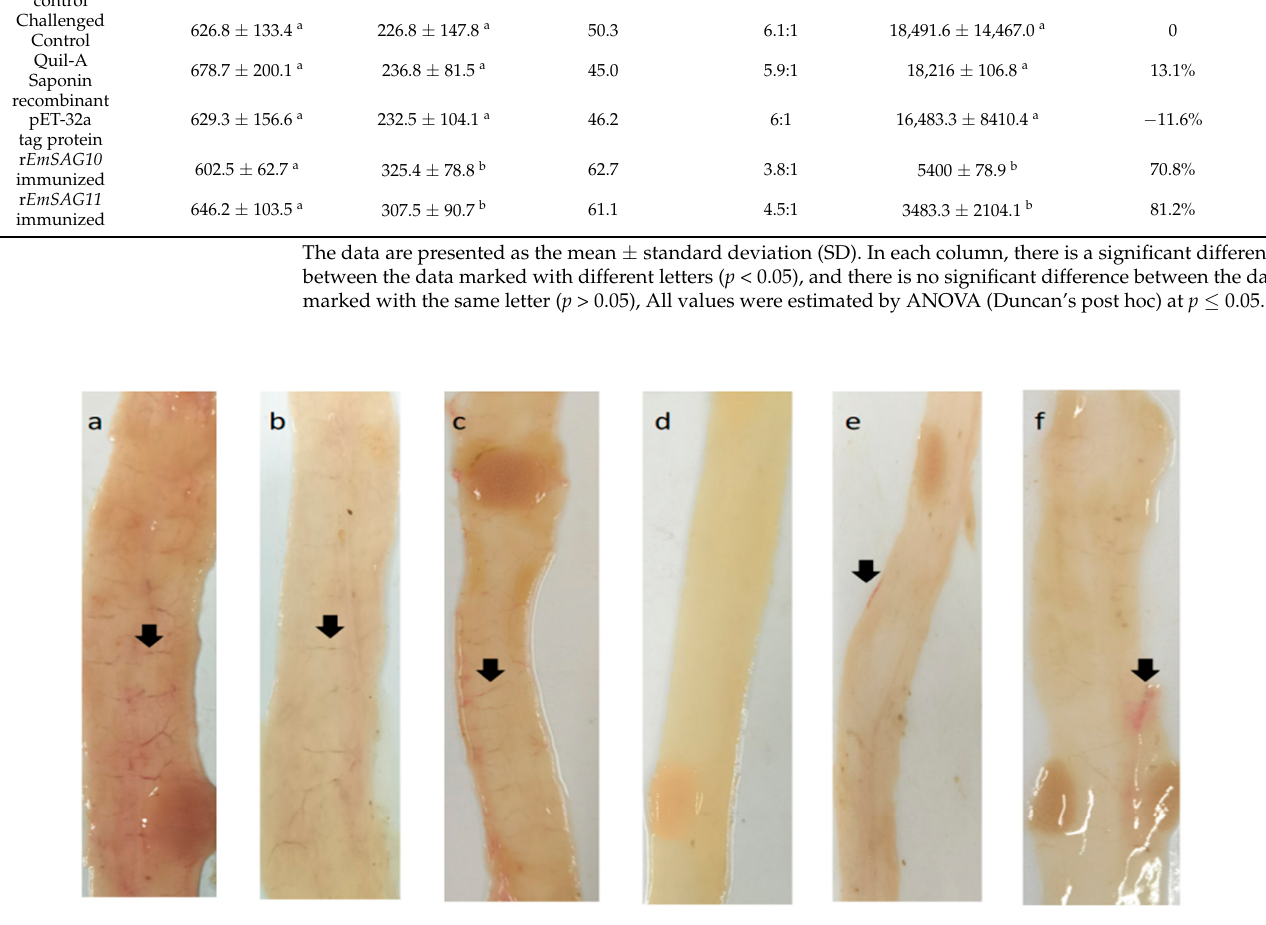
Figure 5. Dissection of the middle and lower segments of the small intestine in each group. ( a ), challenged control group; ( b ), recombinant pET-32a tag protein control group; ( c ), quil-A saponin control group; ( d ), intestinal tract of the blank control group; ( e ), r Em SAG10 immune group; ( f ), r Em SAG11 immunized group. Note: The black arrow indicates intestinal bleeding or congestion. Compared with the control group, the relative weight gain rates of r EmSAG10 and Table 2. Protective effects of r EmSAG10 and r EmSAG11 against an E. magna infection under different r EmSAG11 immunized rabbits were 62.7% and 61.1%, respectively ( p > 0.05) (Table 2). In evaluation indicators. addition, the oocyst yield in rabbits immunized with r EmSAG10 (70.8% oocyst decrease rate) and r EmSAG11 (81.2% oocyst decrease rate) was significantly decreased ( p < 0.05). Compared with the challenged control (6.1:1), quil-A control (5.9:1) and recombinant pET- 32a tag protein control (6:1) positive control group, r EmSAG10 (3.8:1) and r EmSAG11 (4.5:1) were the immunized group had a better feed conversion